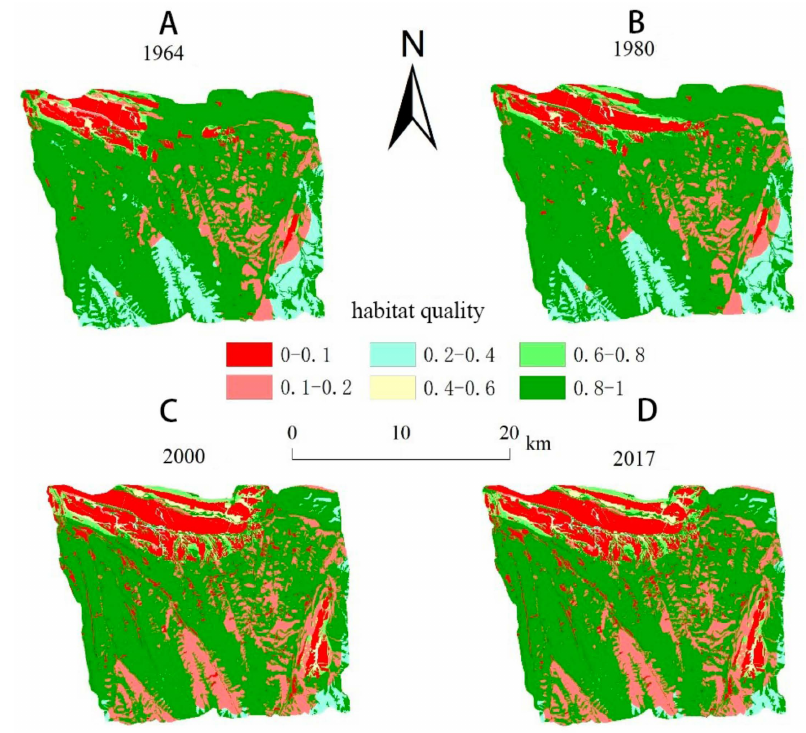
Figure 4. Spatial and temporal distribution characteristics of habitat quality from 1964 to 2017 in Mohe